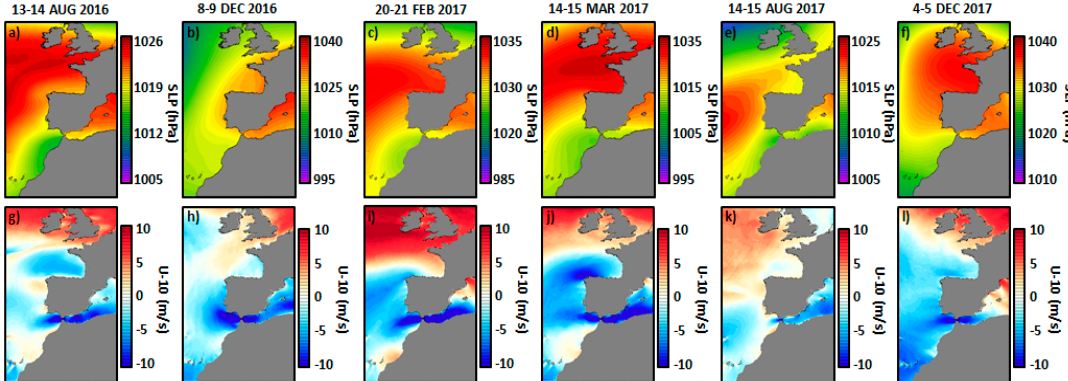
Figure 7. Synoptic patterns related to the six Atlantic Jet (AJ) inflow reversal events analyzed during the period 2016–2017: 2-day averaged maps of sea level pressure (SLP: a – f ) and zonal wind at 10 m